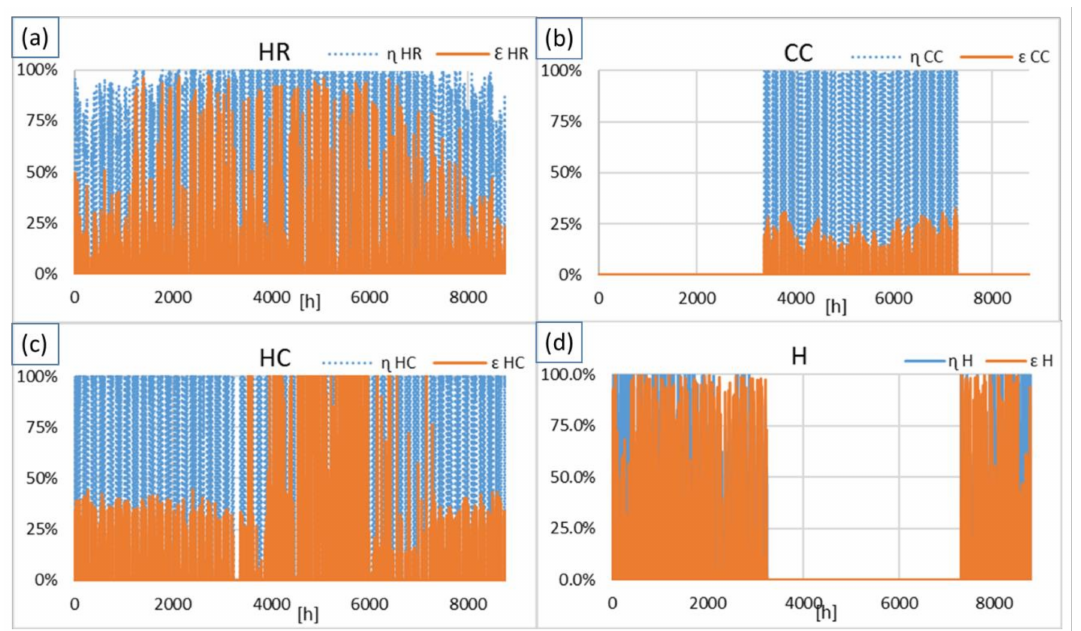
Figure 17. Energy and exergy efficiency of AHU components in Madrid ( a ) HR ( b ) CC ( c ) HC ( d ) H. The average global energy efficiency of the AHU is η AHU = 35% and average global exergy efficiency is ε AHU =